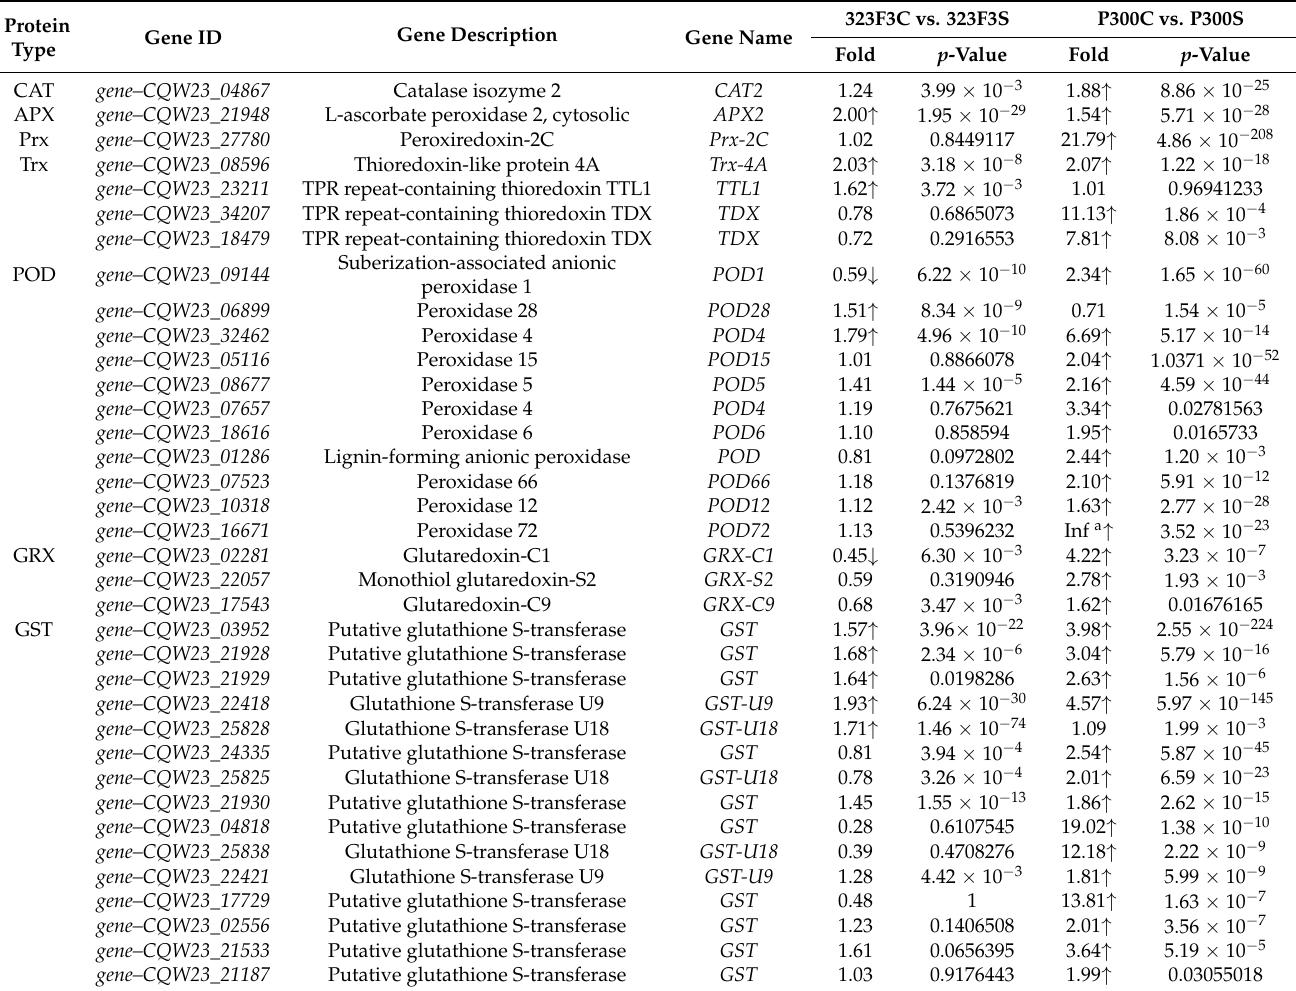
(Table 1), and the read counts in P300S were significantly more abundant in comparison with 323F3S (Table S3). Thus, these DEGs might also contribute to the salt adaption of P300. Table 1. The up-regulated genes associated with ROS scavenging in 323F3C vs. 323F3S and P300C vs.